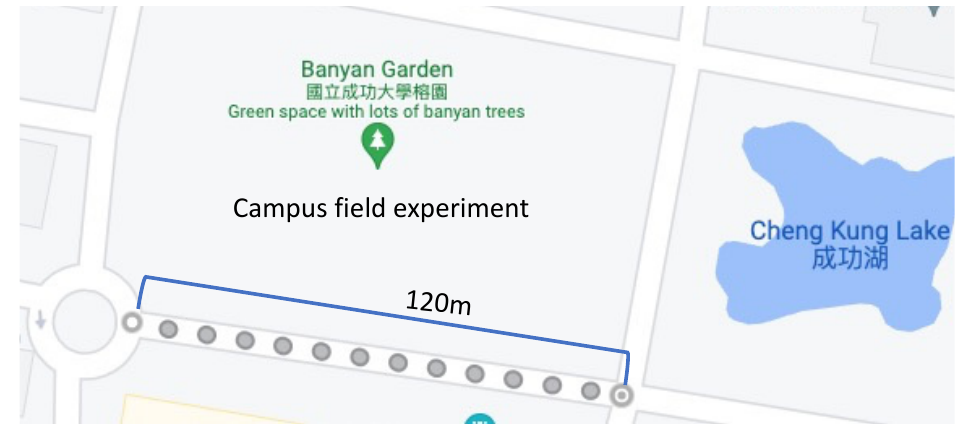
Figure 9. Experiment field of TMP (in NCKU campus).